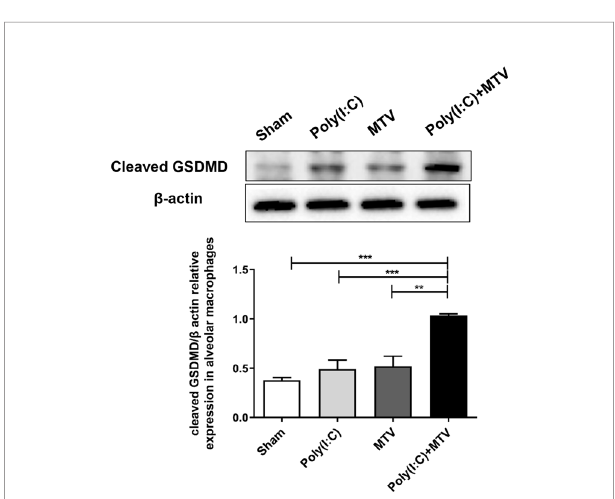
FIGURE 6 | Alterations of protein levels of cleaved GSDMD in alveolar macrophages following Poly(I:C)-MTV. Compared to the sham group, there was no signi fi cant increase in GSDMD expression in alveolar macrophages from mice treated with Poly(I:C) or MTV alone. MTV following Poly(I:C) instillation resulted in a signi fi cant increase of cleaved GSDMD in alveolar macrophages. Results are shown as means ± SEM (n=4) and compared by one-way ANOVA and Student-Newman-Keuls test. ** p < 0.01, *** p <